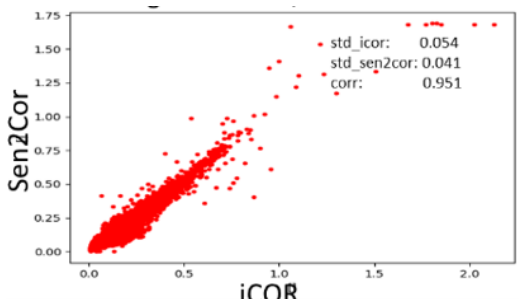
Figure 4. Scatterplot, iCOR & Sen2Cor difference reflectance. Stuttgart area 2018/05